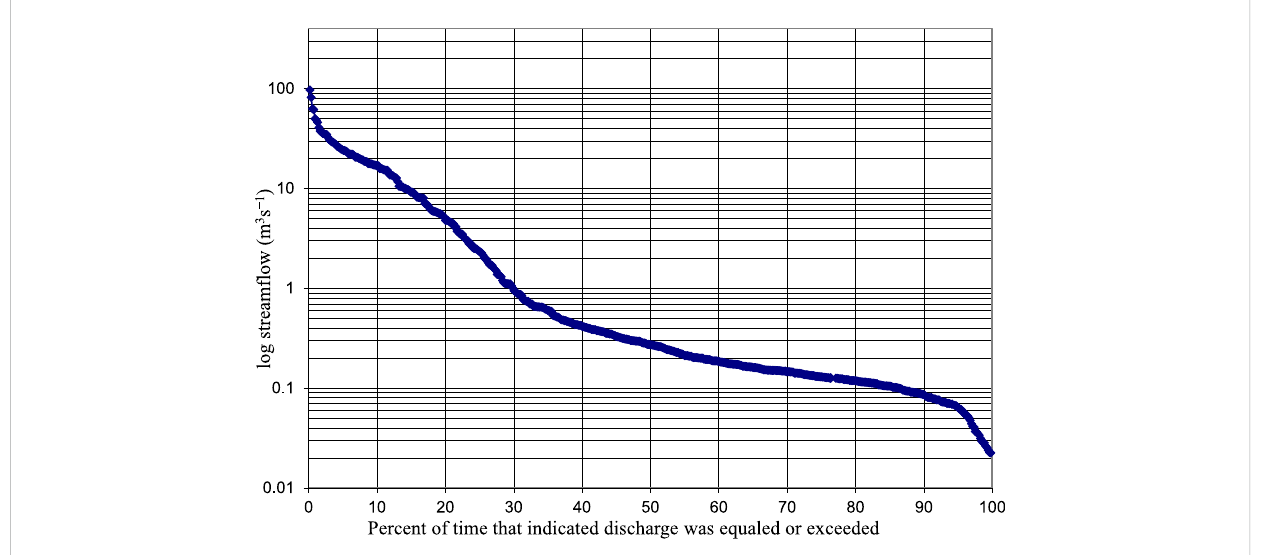
FIGURE 8 Flow duration curve (FDC) of the Chacha River gauging station.